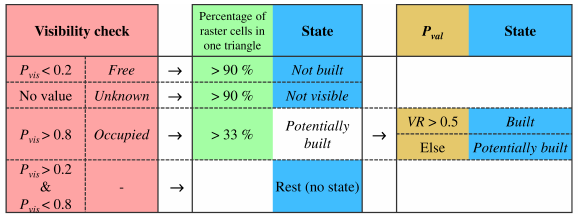
Table 1. Dependencies of states.